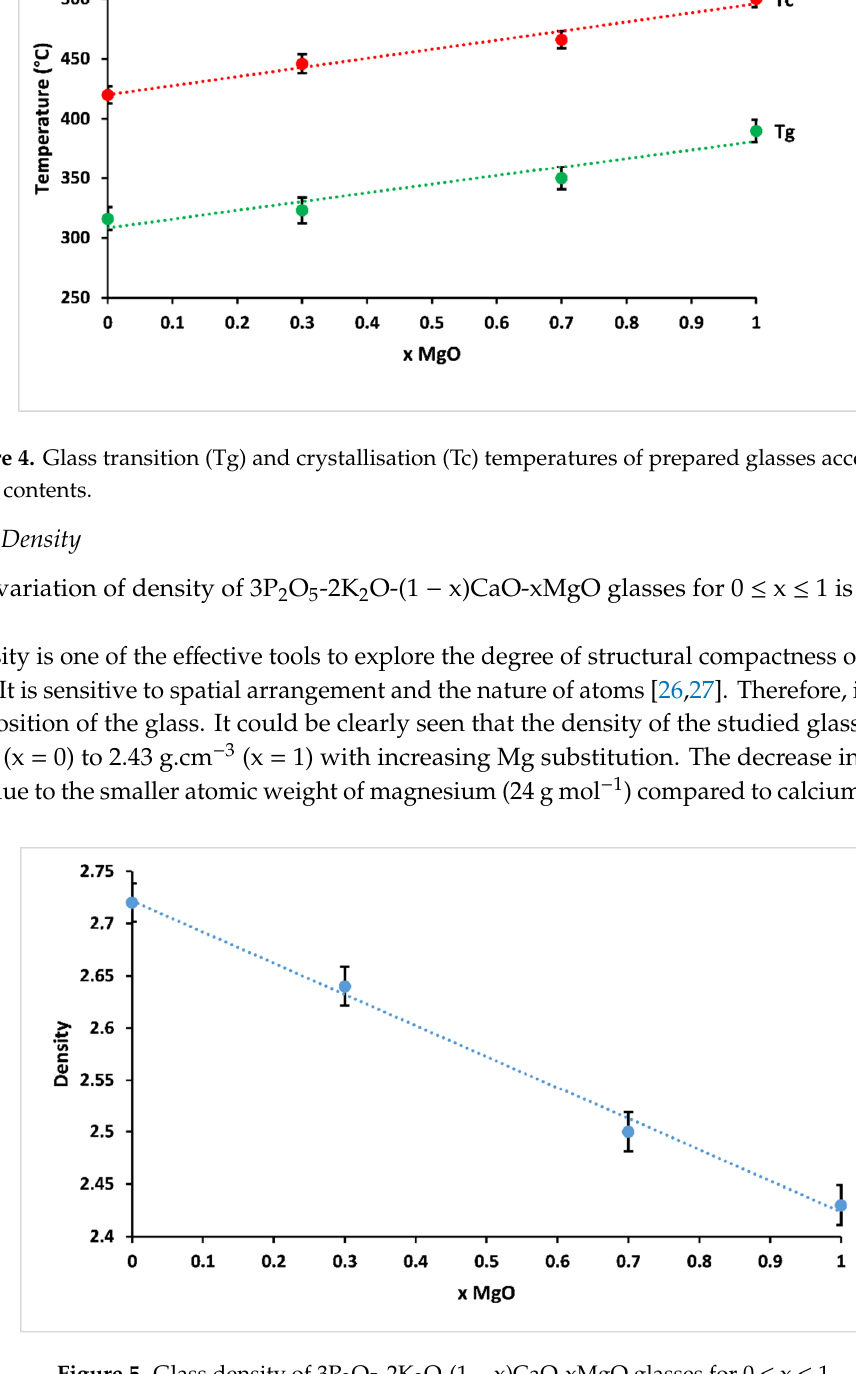
− x)CaO-xMgO glasses for 0 ≤ x ≤ 2 O 5 -2K 2 O-(1